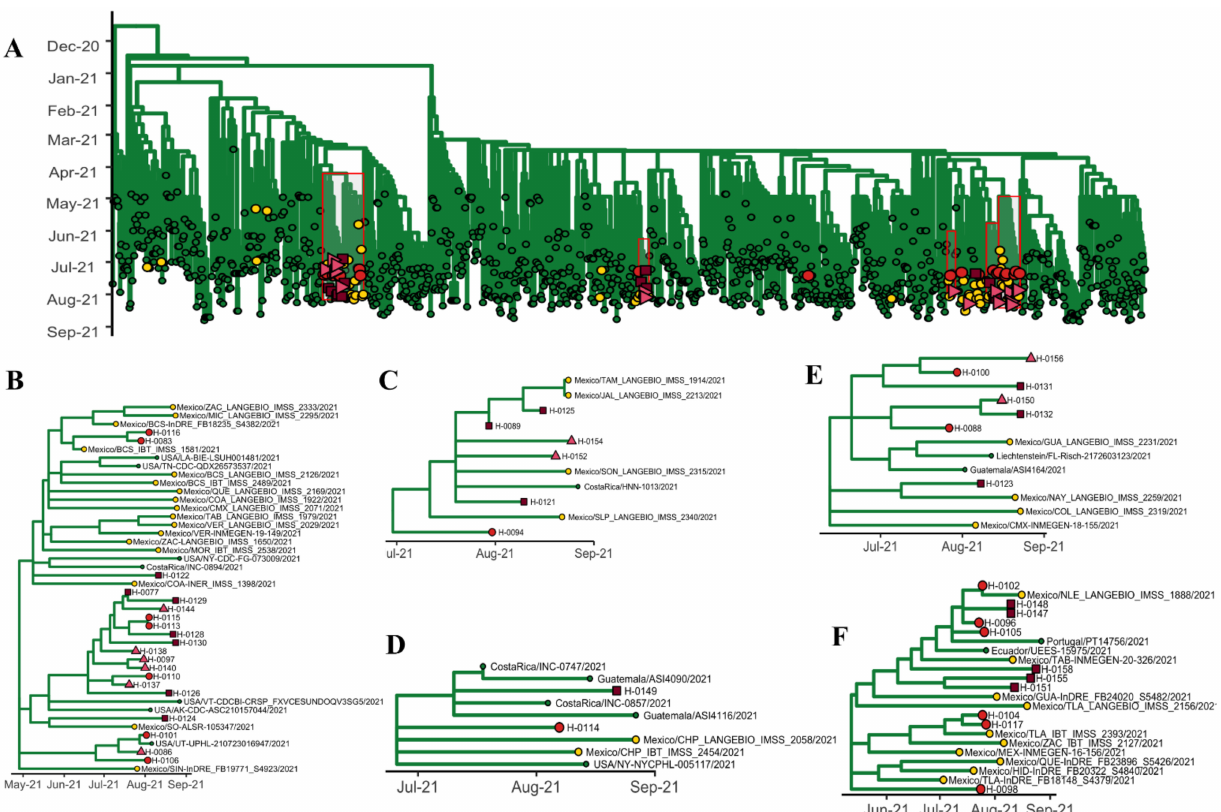
Figure 2. Delta variant phylogenetic relationship. Phylogenetic tree showing the analyzed Delta viruses and the distribution of the obtained sequences ( A ). Red boxes indicate posterior magnification of the analyzed clades, which are the following: the largest clade involving 20 of the generated sequences ( B ) and the minor clades in which the obtained sequences grouped with other Mexican isolates ( C – F ). Yellow circles indicate viruses isolated in Mexico. Red circles indicate ambulatory vaccinated patients. Red squares indicate hospitalized vaccinated patients. Pink triangles indicate hospitalized non-vaccinated patients. Sequences used in this analysis were downloaded from the Global Initiative for Sharing All Influenza Data (GISAID)